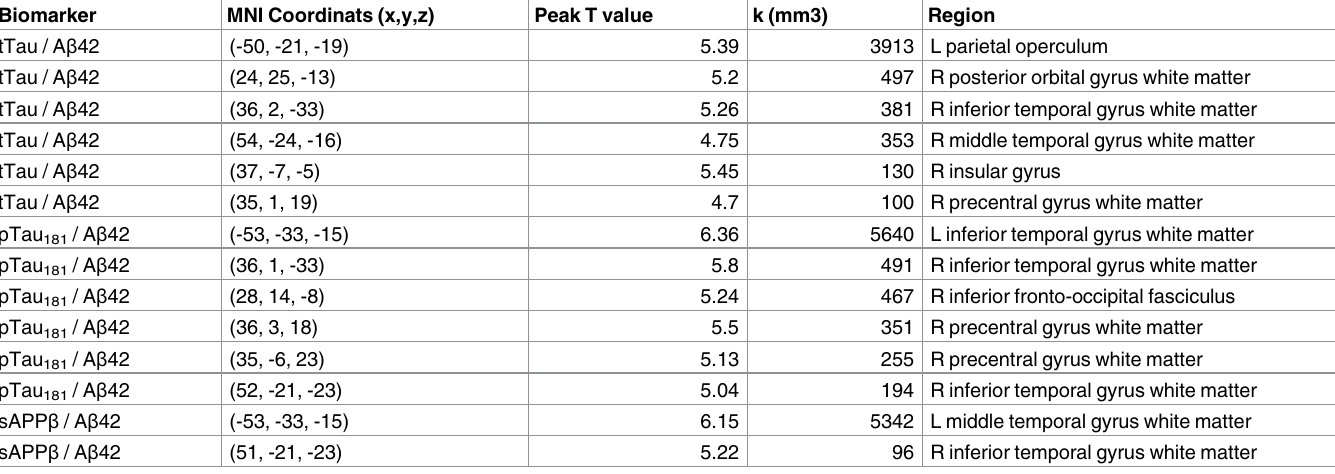
Table 7. Listing of all significant clusters for which the DTI MD was correlated to one of the predictors. Biomarker